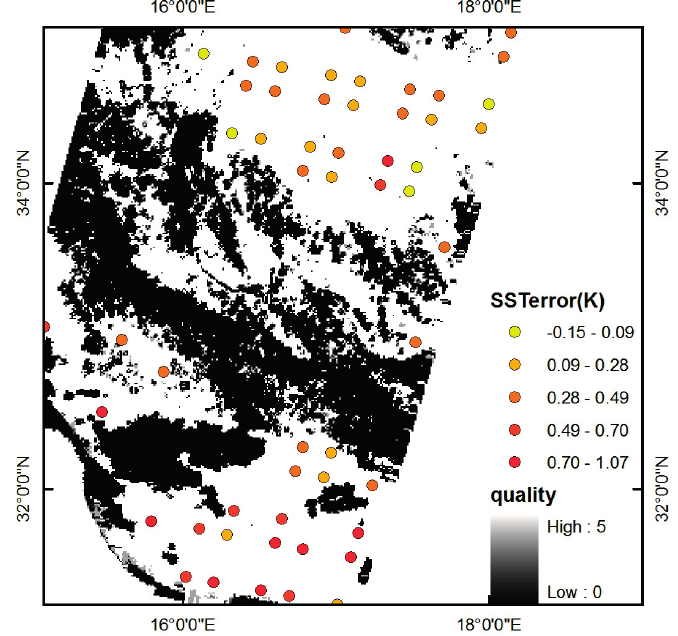
Figure 12. Error of the retrieved ST (IASI-AVHRR) plotted on a quality image of Metop-A AVHRR SST product over a typical part of the Mediterranean Sea on 4 November 2014. (SSTerror = SST iasi − SST avhrr